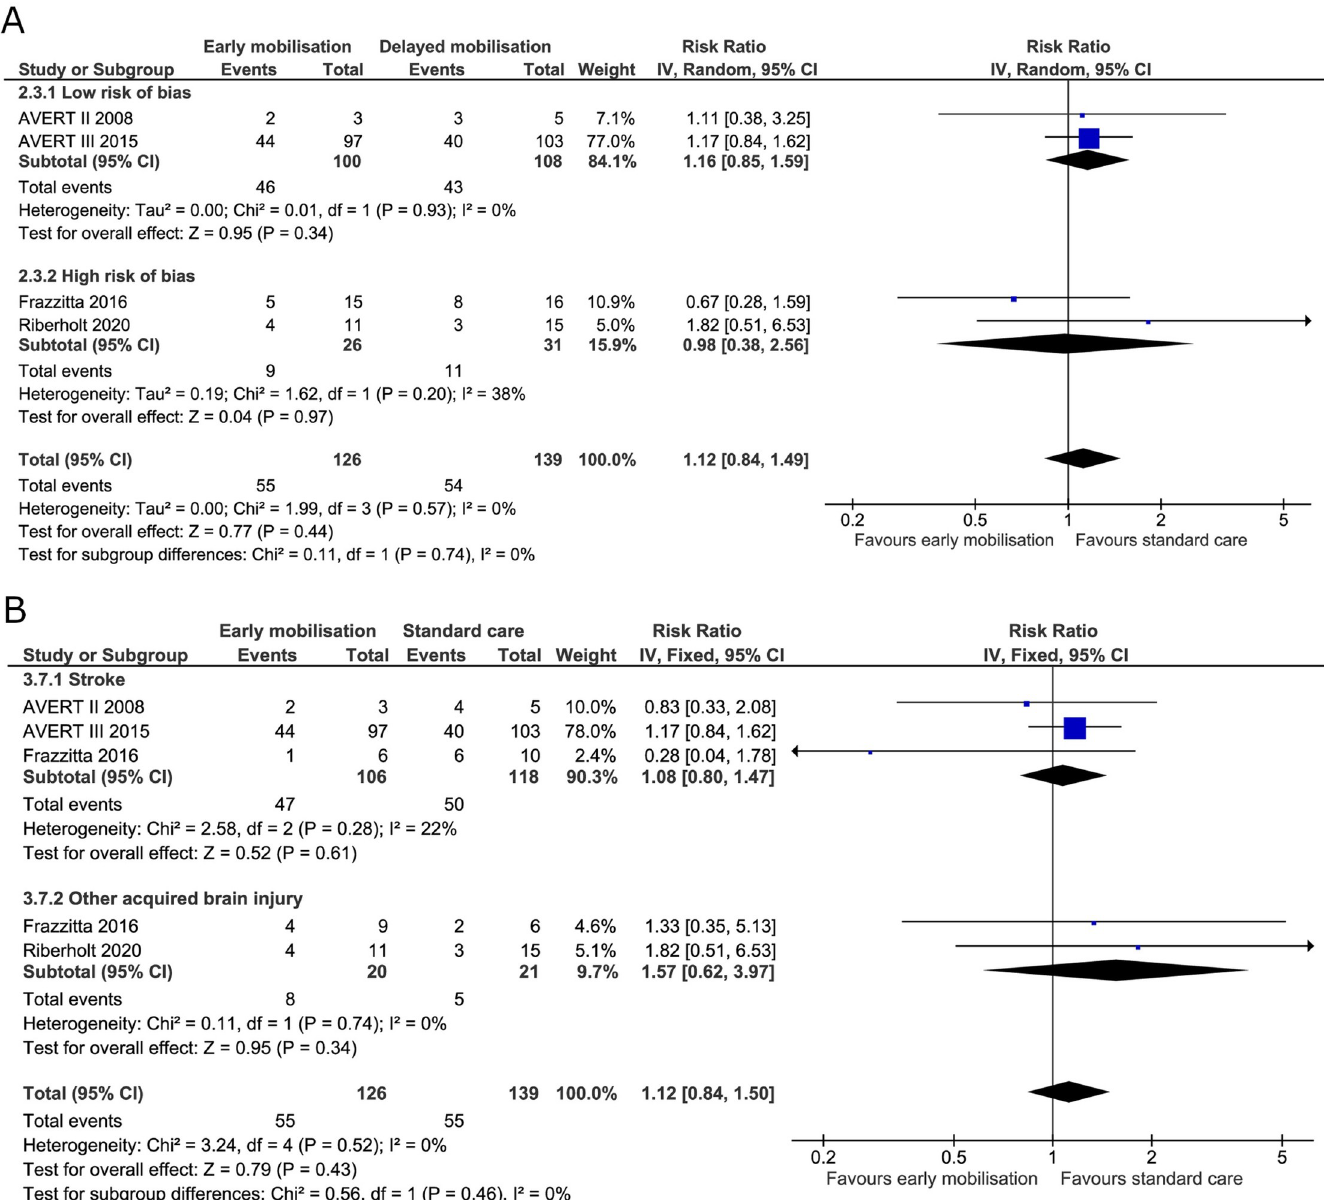
Fig 9. Comparison of early mobilisation versus standard care–Poor functional outcome among survivors at maximal follow-up. Figs 9A and 8B. Forest-plot showing the results from the fixed-effect meta-analysis of the outcome poor functional outcome at the longest follow-up with subgroup divided according to risk of bias (A) or diagnosis